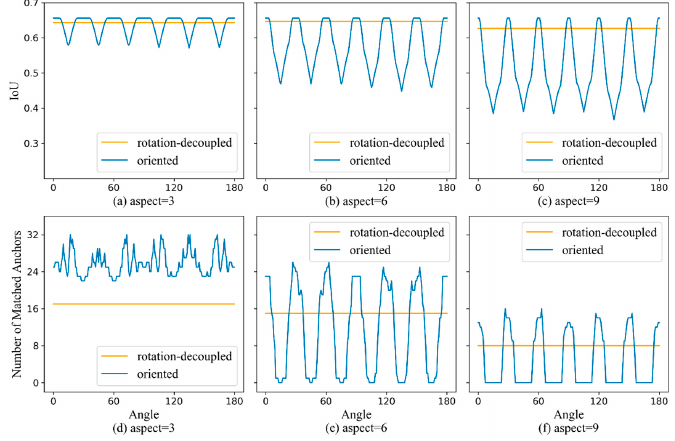
Figure 4. An example of matching results using the proposed strategy and OBB-based strategy. The top row demonstrates the matching results using the strategy based on oriented anchors and the bottom row presents the matching results using the proposed strategy. The blue box represents the ground truth box, the red box represents the anchor with the largest IoU matched and the green box represents the decoupled bounding box.